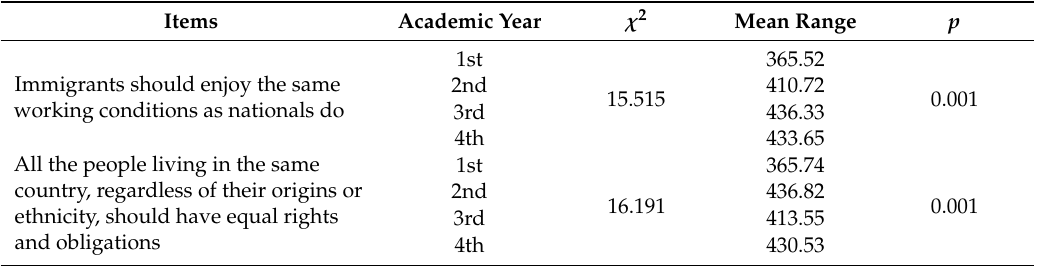
Table 4. Immigration and Social Rights. Positive attitudes according to the variable: academic